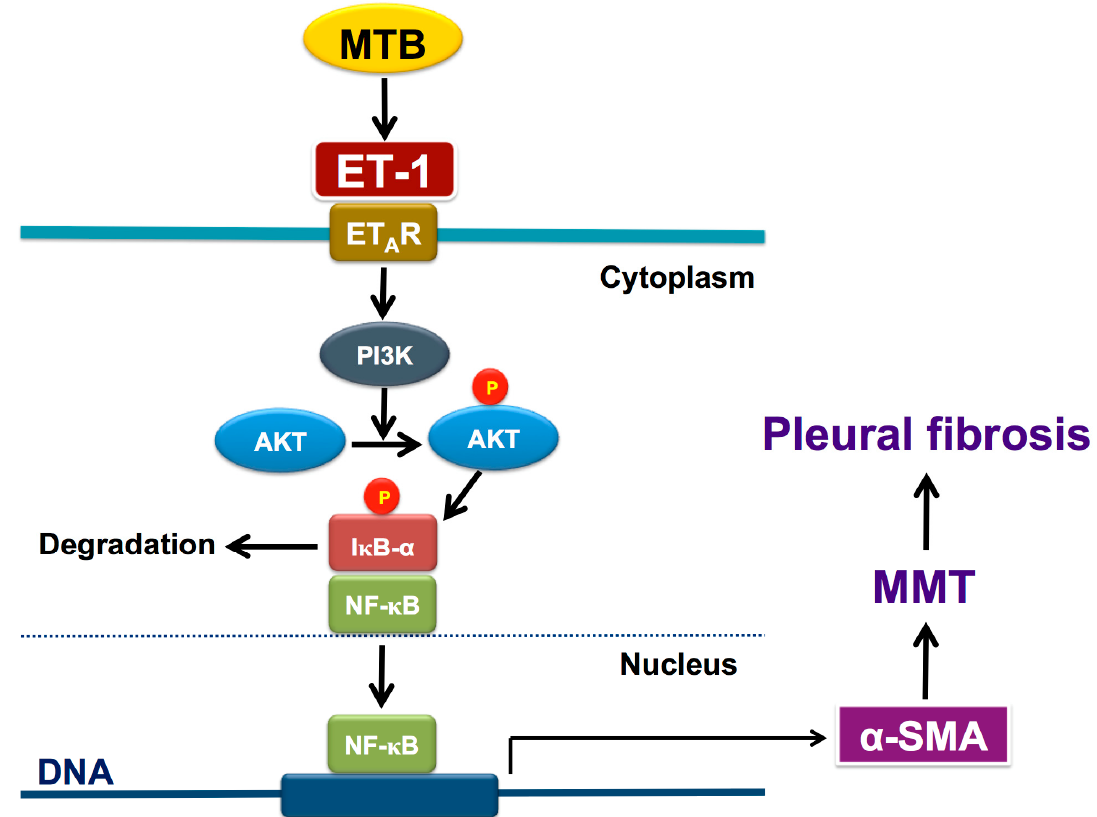
Figure 7. Schematic diagram of the activated signalings of MMT in human pleural mesothelial cells upon Mycobacterium tuberculosis infection and ET-1 stimulation. Mycobacterium tuberculosis induces production of ET-1 that binds to ET-A receptor and results in phosphorylation of PI3K/AKT and activation of NF- κ B, leading to expression of α -SMA and subsequent MMT and pleural fibrosis (see text for further explanation). ℗ phosphorylated; AKT, protein kinase B; α -SMA, α -smooth muscle actin; ET-1, endothelin-1; ET A R, ET-A receptor; I κ B- α , inhibitor of κ B- α ; MMT, mesothelial mesenchymal transition; MTB, Mycobacterium tuberculosis ; NF- κ B, nuclear factor- κ B;